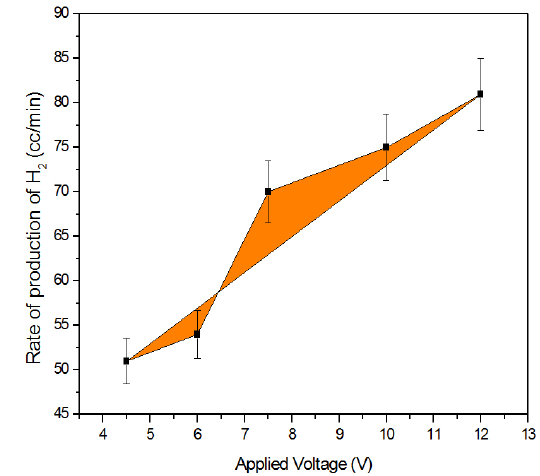
Figure 4. Effect of temperature on the production of hydrogen gas: Dimensional of graphite rod: 80 × 20mm; Pressure: 1 atm; Electrolyte concentration: 0.03 M; Applied voltage: 12 V; Applied Current: 1.2 A; Medium: Distilled water; Reaction Time: 10 mts and Distance between the electrodes: 2 cm.